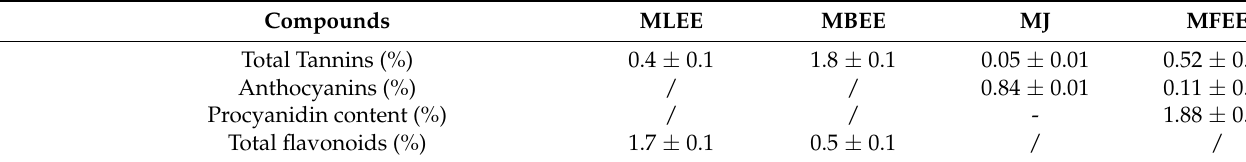
Table 2. Content of phenolic compounds identified in black mulberry leaf ethanol extract (MLEE), black mulberry bark ethanol extract (MBEE), black mulberry juice (MJ) and black mulberry fruit ethanol extract (MFEE) (mean of measurements performed in triplicate ± SD).